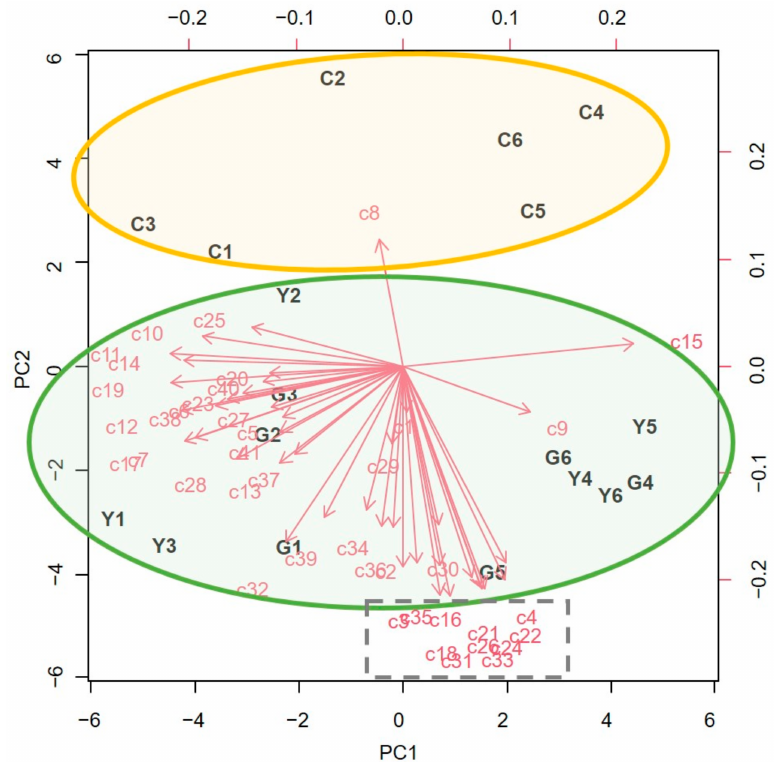
Figure 3. PCA of the proportion of the compounds (c1–c42, see Table 1 for respective compound names) detected in the volatile profiles of control (C), Achillea millefolium (Y), or Allium sativum (G) treated tomato plants. Samples of treated plants (Y and G) are grouped within the green ellipse, whereas the control samples are within the yellow ellipse. The compound characteristics of treated plants are grouped within the dotted grey box. Before the analysis, data (i.e., peak proportions) were transformed using the arcsin (sqrt x) function.